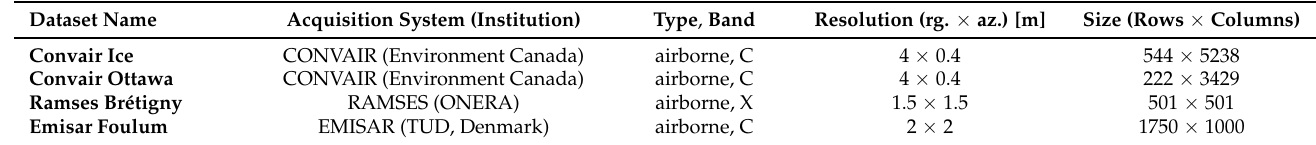
Figure 3. Pauli color composites for polarimetric data: ( a ) Convair Ottawa. ( c ) Convair Ice. ( e ) Ramses Brétigny. ( f ) Emisar Foulum. Absolute value of NRF parameter: ( b ) Convair Ottawa. ( d ) Convair Ice. Table 4. Monostatic full-polarimetric datasets used in the